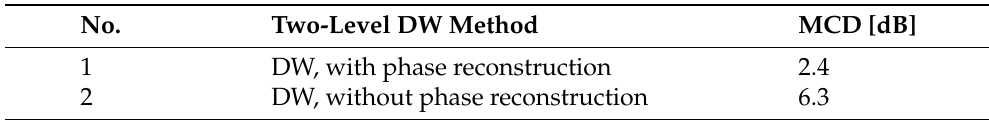
Table 1. MCDs obtained for 2-Level DW with and without GLA.